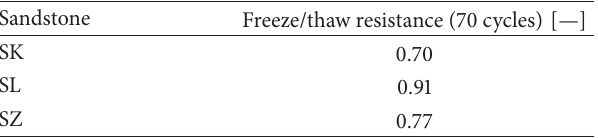
Table 6: Freeze/thaw resistance.